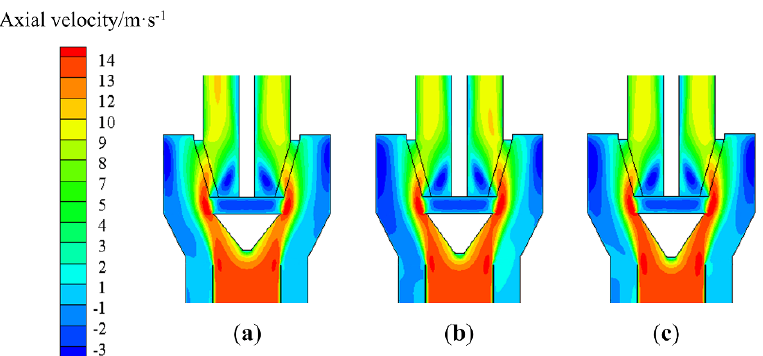
Figure 19. Effect of the height of the diversion cone on the axial velocity (T-D (1-0.7) , x = 0): ( a ) h = 94 mm, ( b ) h = 104 mm, and ( c ) h = 114 mm.